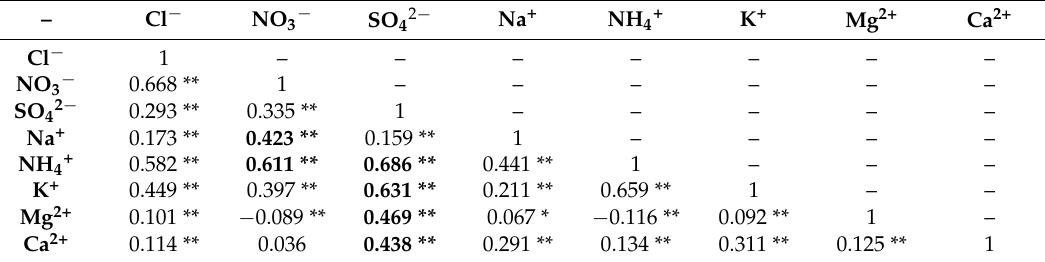
Table 4. Pearson correlation of the water-soluble ions in PM 2.5 in the summer.